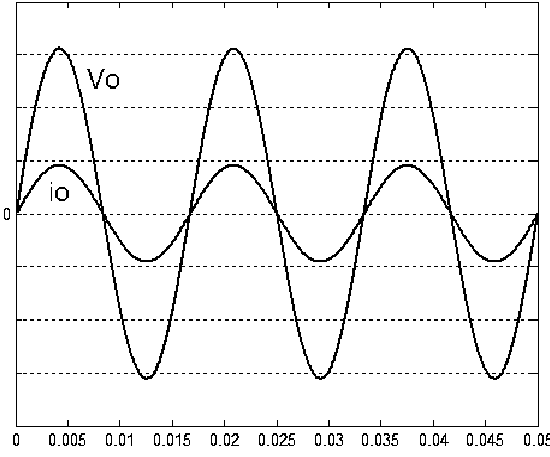
Figure 3. Output voltage and current for simulation of the conventional limited ‐ time convergent VSC at full load (vertical: 50 V/div and 15 A/div).